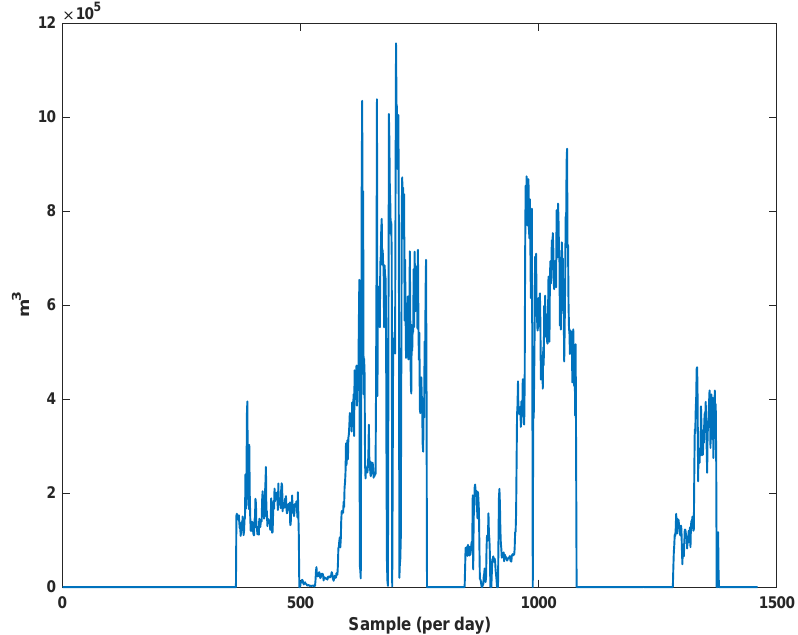
Figure 9. The trajectory of consumption line 2.